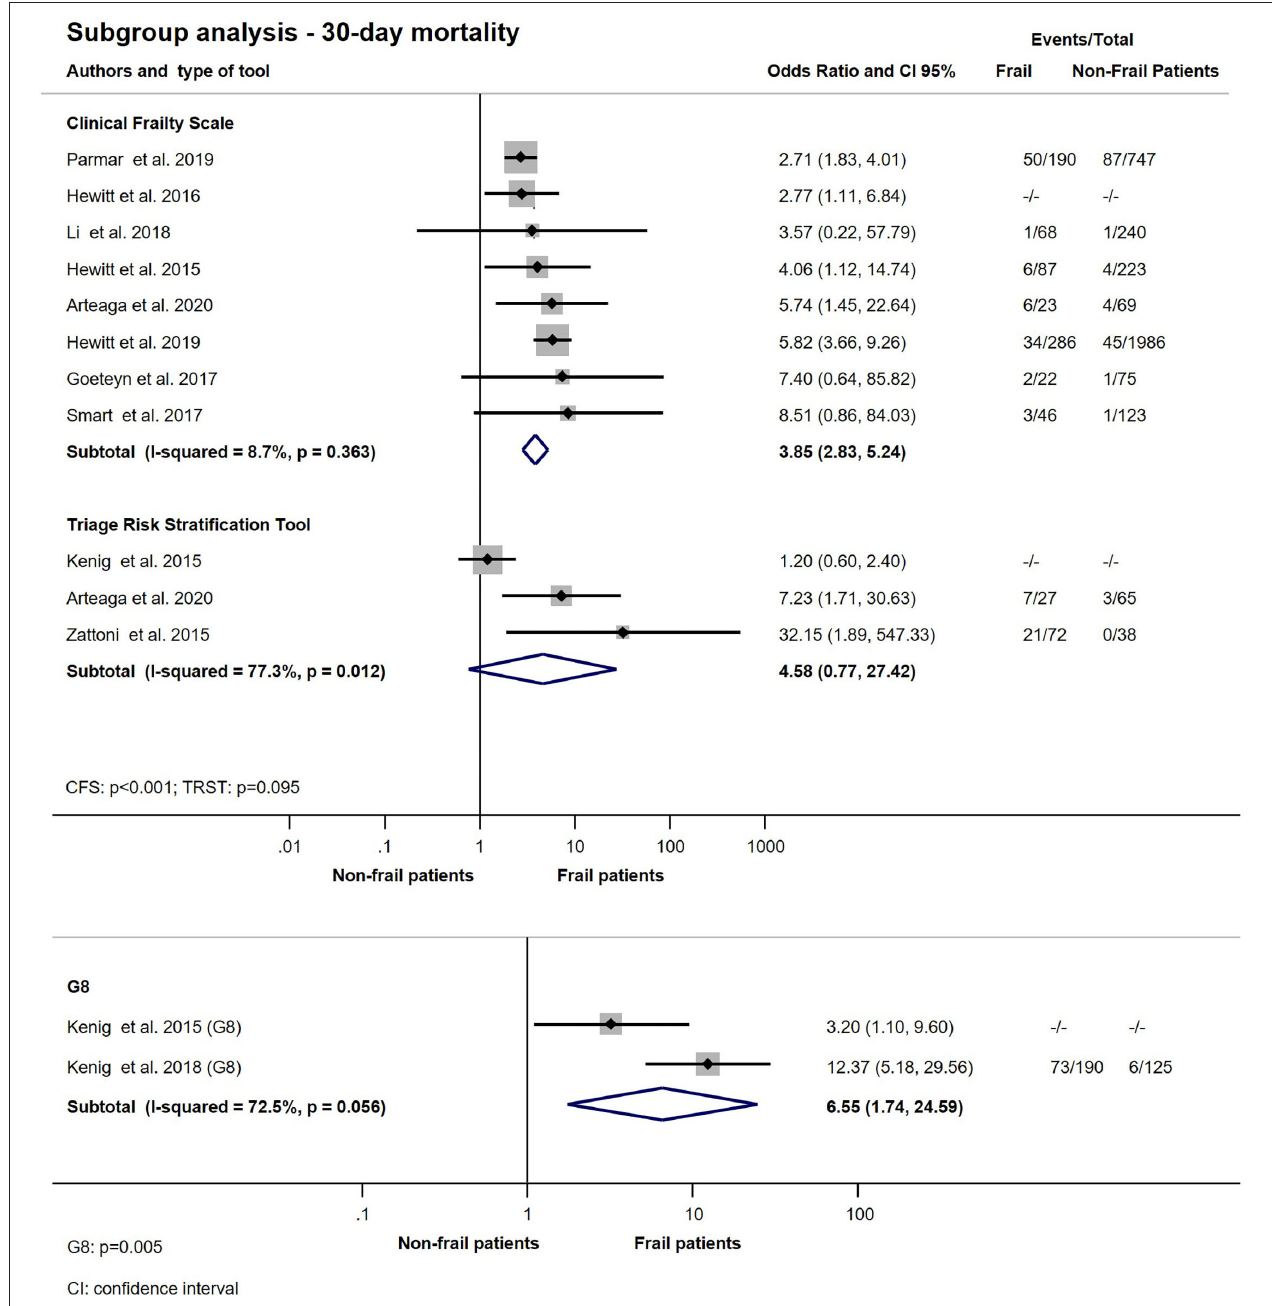
FIGURE 3 | Subgroup analysis − 30-day mortality for emergency surgical patients living with frailty compared to non-frail patients. In the CFS subgroup frail patients (CFS > 4) have higher odds of 30-day mortality (OR: 3.85; CI: 2.83–5.24). In the frail TRST group (TRST > 2) the overall OR of 30-day mortality was 4.58; CI: 0.77–27.42. Frailty assessed with G8 showed that patients living with frailty had higher chance of dying within 30 days after hospital admission (OR: 6.55; CI: 1.74–24.59). Crude ORs were pooled with the ORs calculated from raw data. Note that heterogeneity might not be not important for CFS, but substantial for TRST and